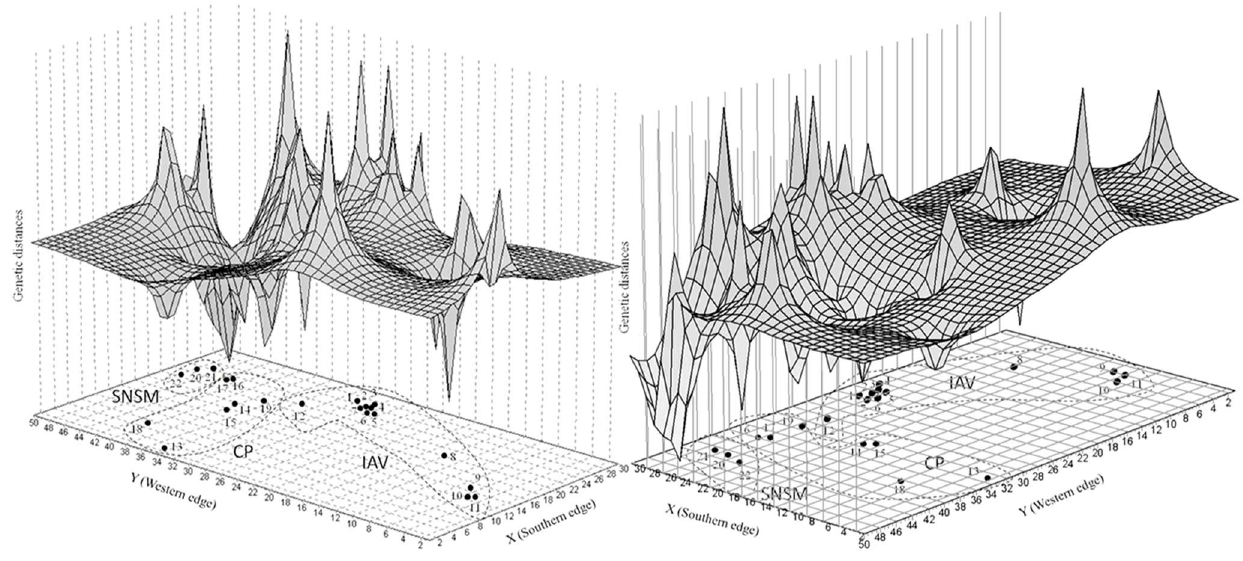
Figure 3. Landscape shape interpolation of genetic distances within T.dimidiata in geographical space in Colombia. A graphical interpolation-based representation of the ND4 gene’s genetic diversity was made using a 30 6 50 grid and a distance-weighting parameter of 1 for T. dimidiata in Colombia. The x- and y-axes represent geographical coordinates, while surface heights along the z-axis indicate genetic distance. Peaks and valleys are indicative of areas with high or low pairwise genetic distance between ND4 haplotypes, respectively. The position of sampling sites in the ‘‘base’’ of the graph is the approximate distribution of localities described in Table 1 and Figure 1.